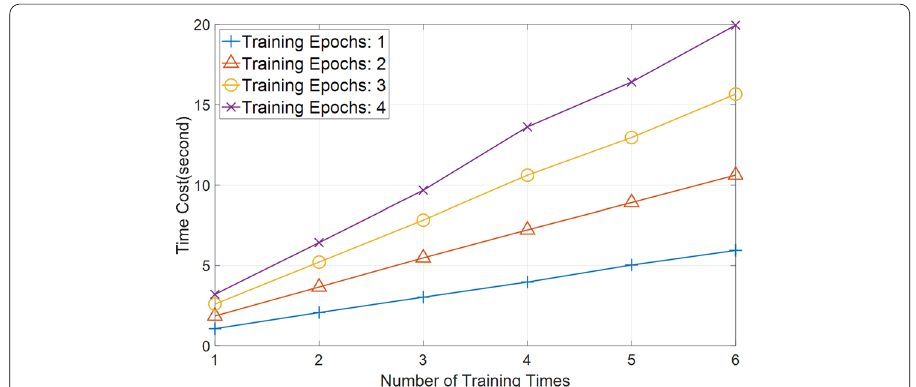
Fig. 18 The time cost of training discriminator. This figure depict the relationship between time costs of training discriminator and the number of training times under different numbers of training epochs